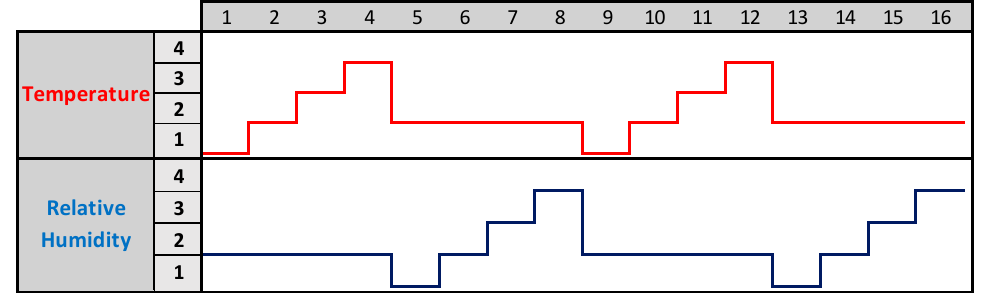
Figure 3. Sequence of trial tests for the evaluation of the effect of environmental conditions on the sensors responses. When temperature varies, relative humidity is maintained constant and vice-versa.